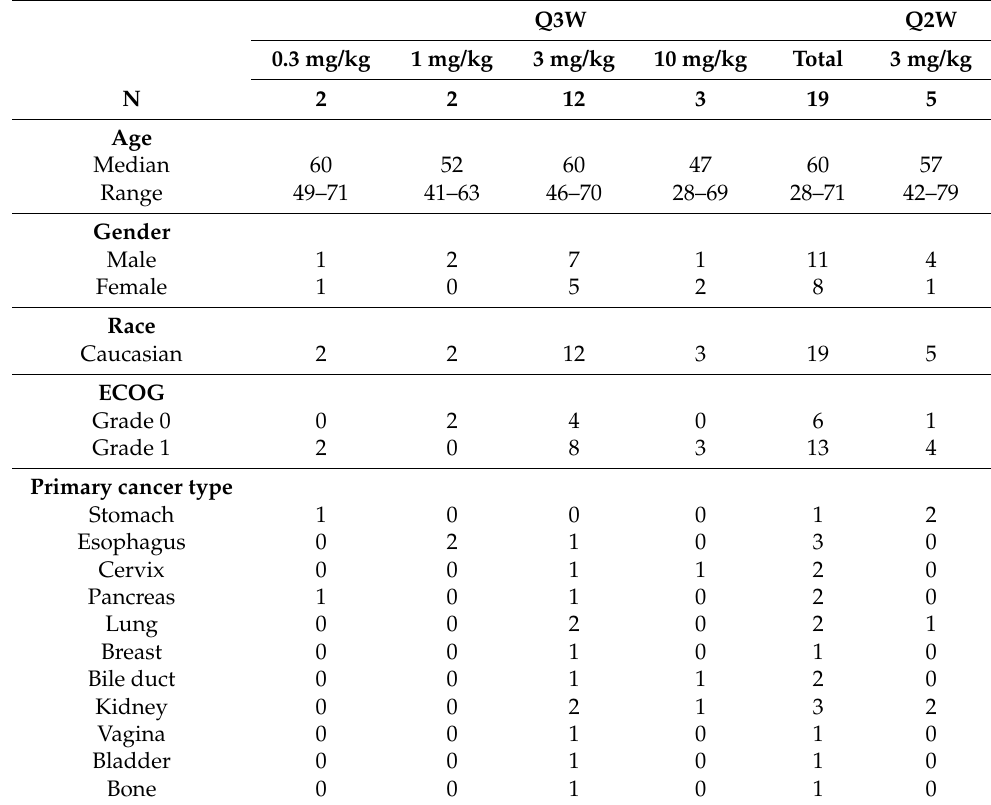
Table 1. Patient demographics and baseline